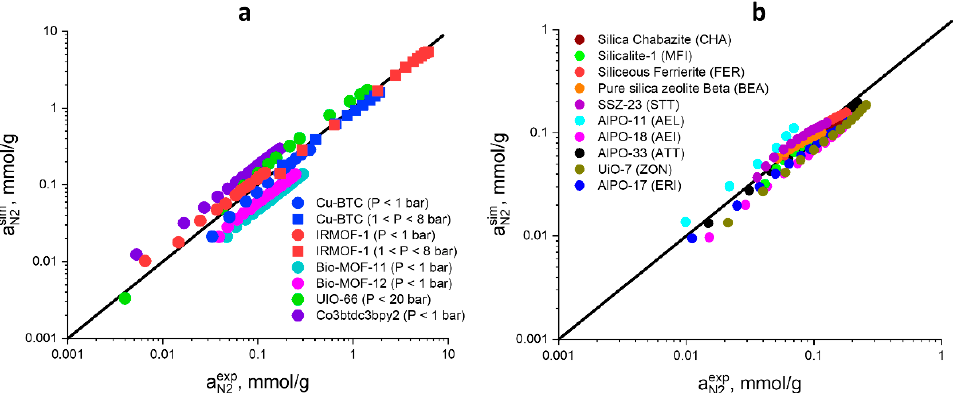
Figure 1. Comparison of experimental and molecular simulation data for N 2 adsorption in MOFs ( a ) and zeolites ( b ).